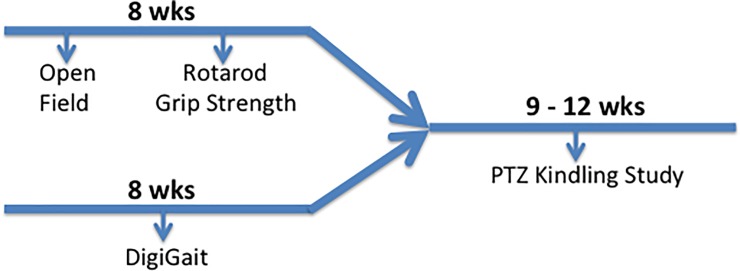
The timeline for utilizing animals in this study.Open field, Rotarod and Grip strength tests were performed on the same group of 8-week-old animals in this as showed above. DigiGait tests were done on naïve 8-week-old animals. After completion of the motor behavior studies, animals were used for the PTZ kindling study.